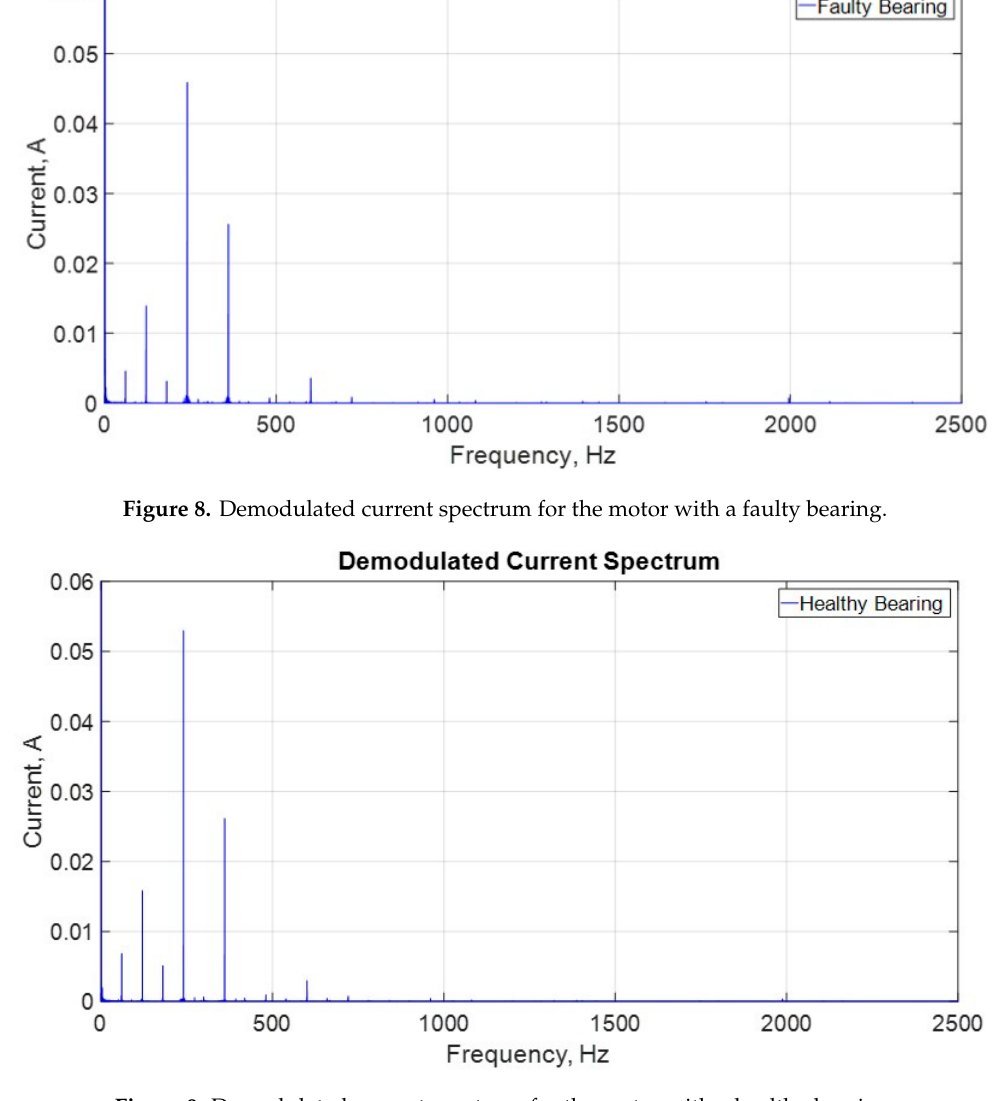
Figure 9. Demodulated current spectrum for the motor with a healthy bearing.